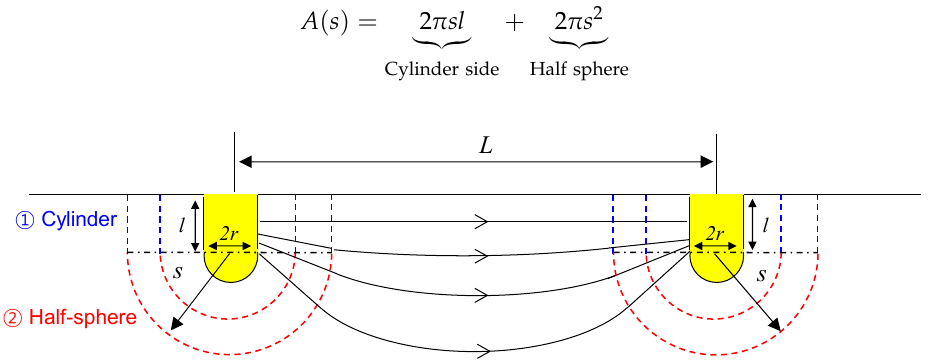
Figure 1. Definitions of the symbols and equipotential surface shape between two cylindrical electrodes.